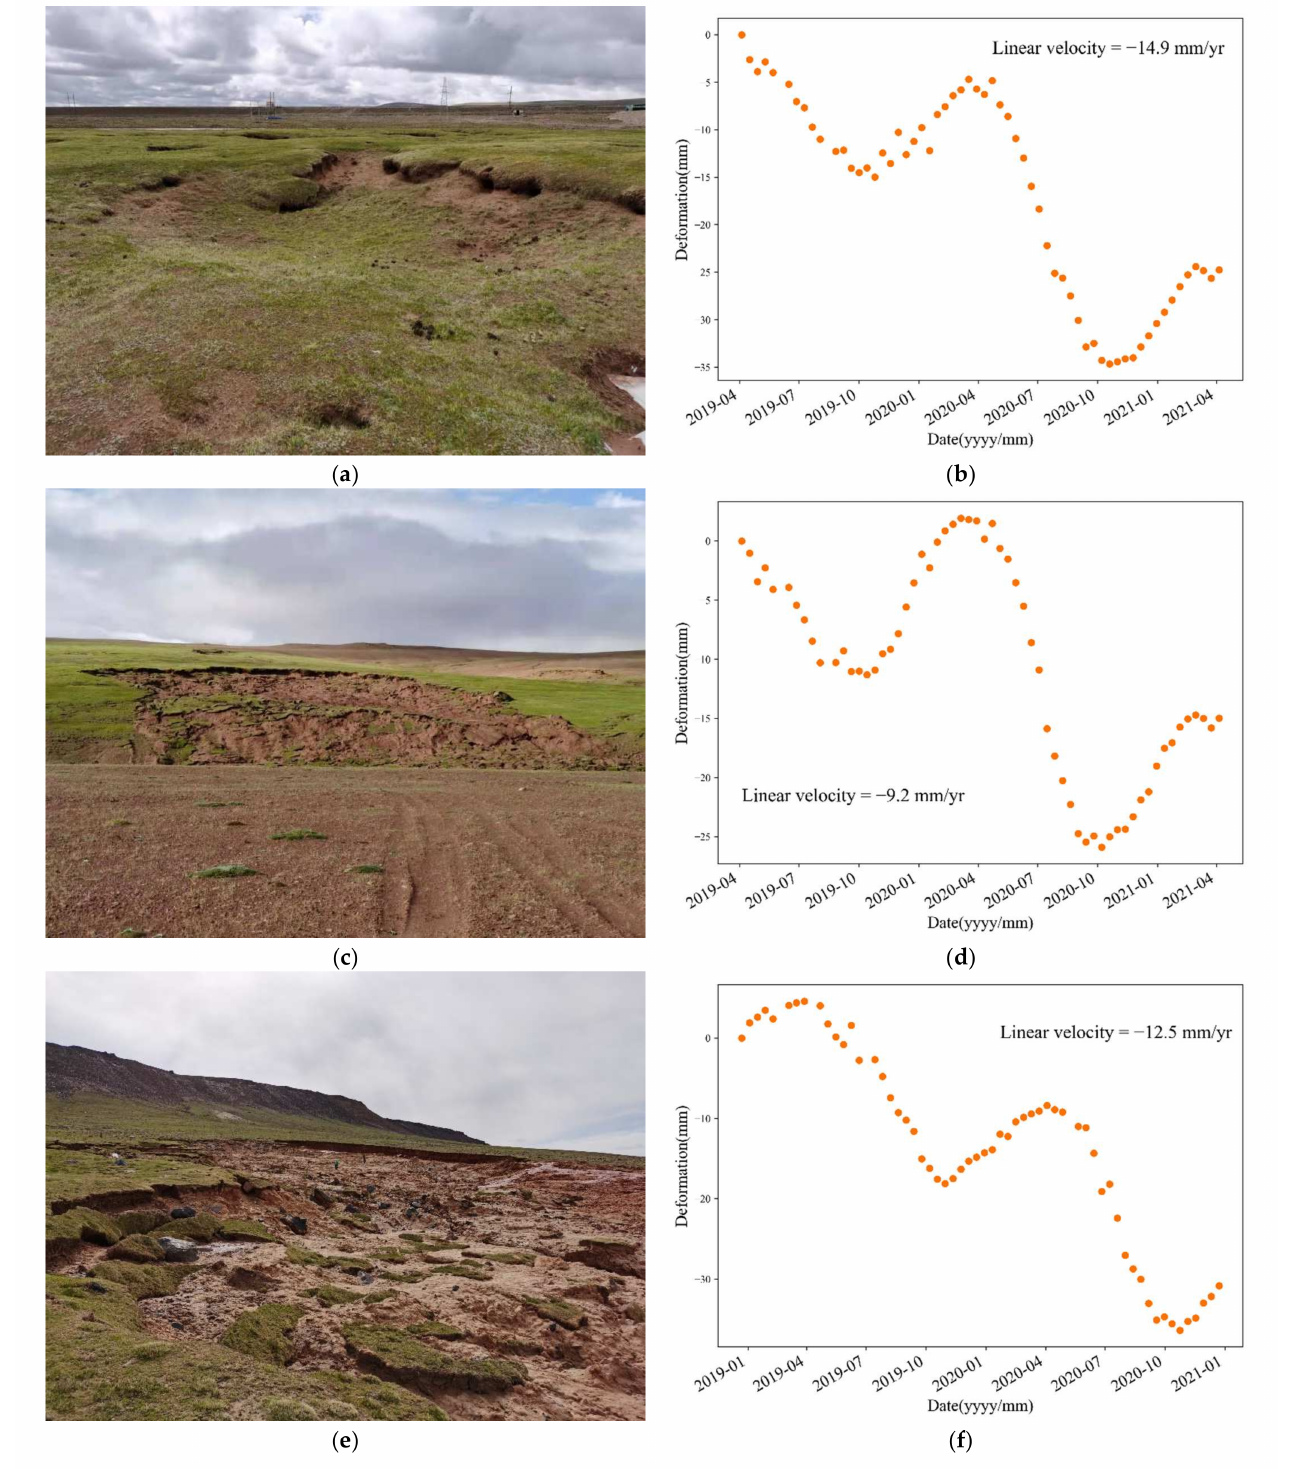
Figure 8. ( a ) Field photo of WDL region; ( b ) time-series deformation results for WDL region; ( c ) field photo of FHS region; ( d ) time-series deformation results for FHS region; ( e ) field photo of SWX region; ( f ) time-series deformation results for SWX